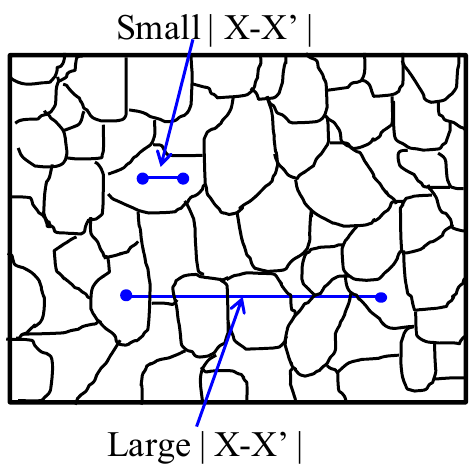
Figure 2. Schematic of the two-point correlation function in polycrystals.